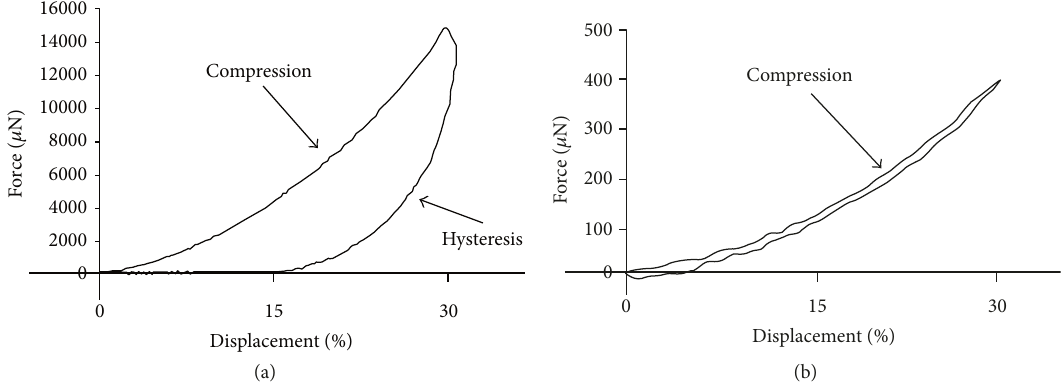
Figure 3: Mechanical properties of the particles. Compressive properties of alginate (a) and Si-HPMC (b) particles were investigated by subjecting them to a 30% compression for 30 seconds. The force ( μ N) and displacement (%) were recorded, and Young ’ s modulus was determined. Alginate and Si-HPMC particles of 1mm diameter were selected for this study.